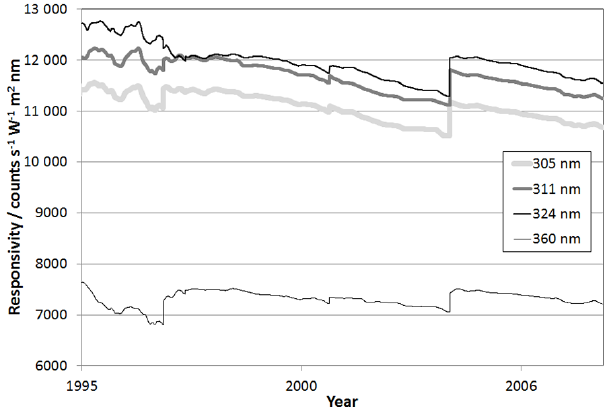
Figure 10. Level2 responsivity of Brewer #107 at different wave- lengths for the time period 20 March 1995–7 April 2008 used for post-processing of solar UV irradiance